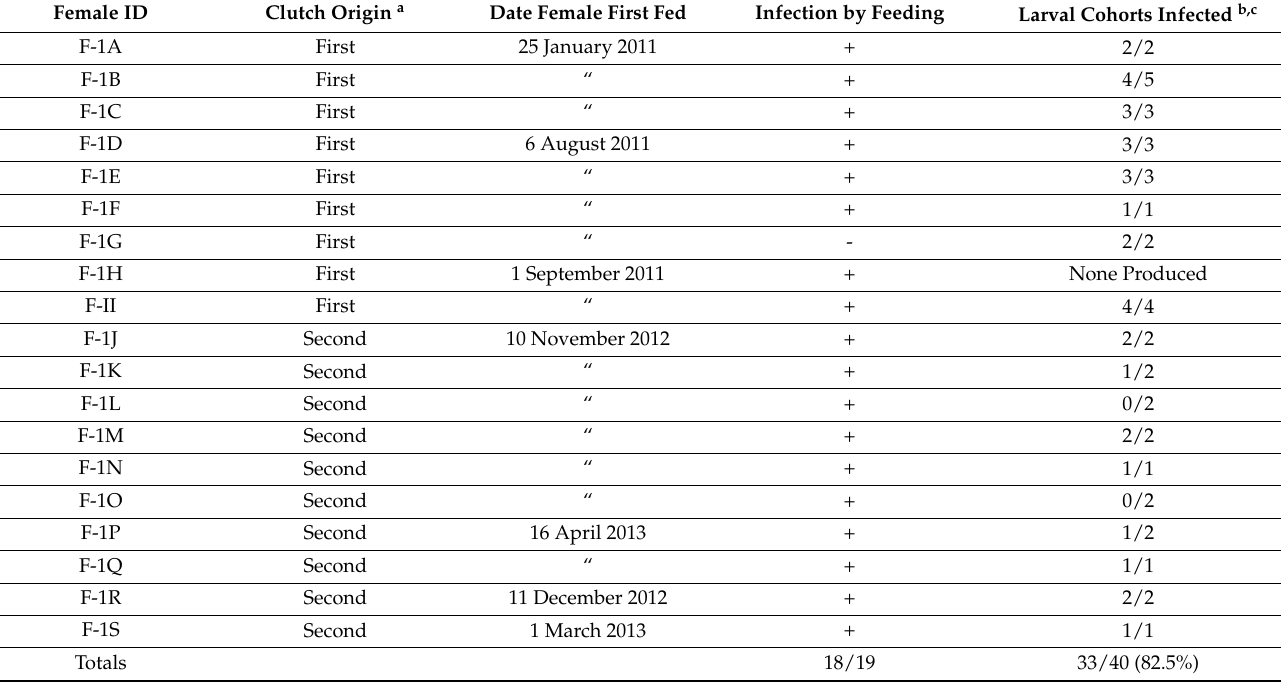
Table 2. Borrelia hermsii infection in F-1 female O. hermsi and larval cohorts assayed by transmission to mice.